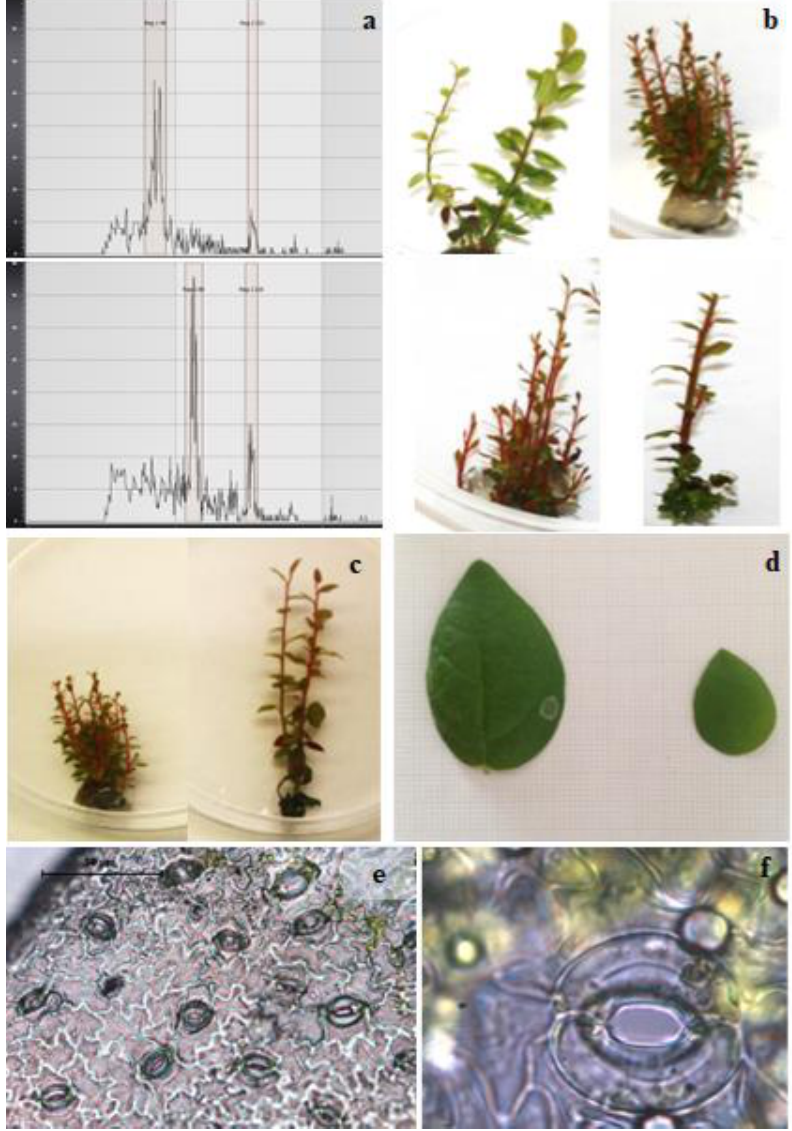
Figure 2. ( a ) Histograms of the flow cytometry of diploid (top) and tetraploid (bottom) shoots. ( b ) Morphological differences among mixoploid shoots. ( c ) Differences between diploid (left) and tetraploid shoots. ( d ) Fully expanded leaf blade of a tetraploid (left) and diploid (right) shoot. ( e ) Stomatal density of the abaxial surface of leaf derived from diploid shoots. ( f ) Stomata from a tetraploid observed under an optic microscope (100 × ).